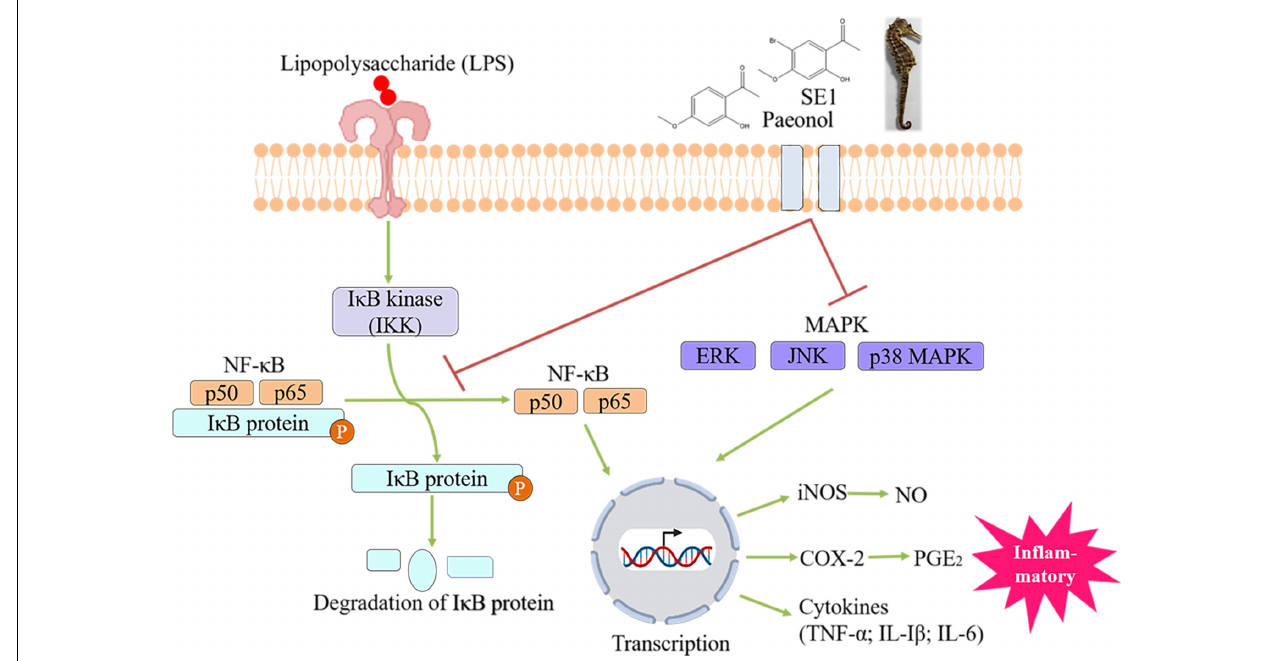
FIGURE 7 | Paeonol and 1-(5-bromo-2-hydroxy-4-methoxyphenyl)ethanone(SE1) from Hippocampus Kuda Bleeker blocked the LPS-stimulated inflammatory responses in BV-2 microglial cell via modulating MAPK and NF- κ B-signaling